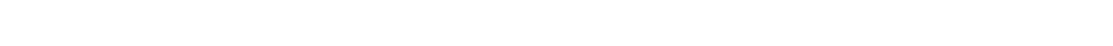
FIGURE 4 | SEM morphology before immersion; bare (A) coated samples at pH 4 (B) and at pH 7 (C) and their corresponding images after 1 day of immersion in SBF are (D) , (E) and (F) respectively. Reproduced with permission from (Ali et al., 2021), Frontiers.